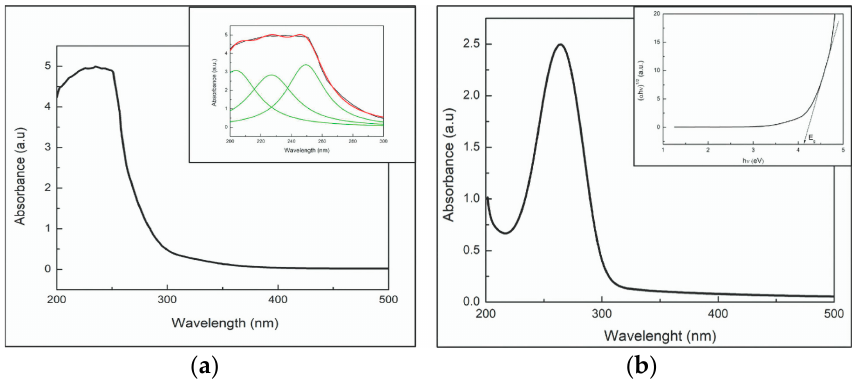
Figure 2. UV–vis spectrum and Tauc method for ( a ) Mo NPs and ( b ) Ni NPs.